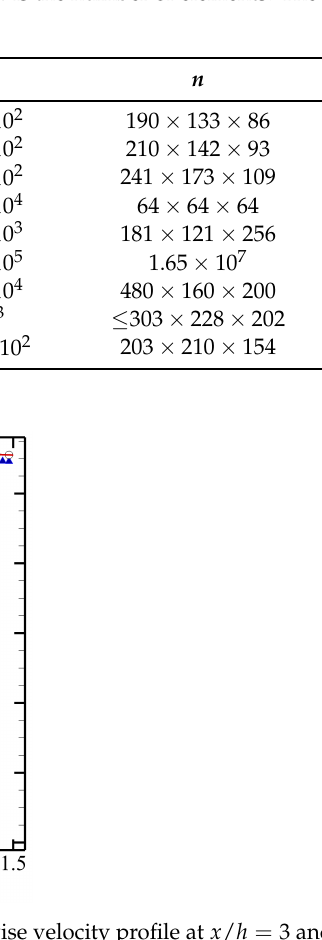
Figure 5. Grid sensitivity study based on streamwise velocity profile at x / h = 3 and y / h = 0 for the long prism.